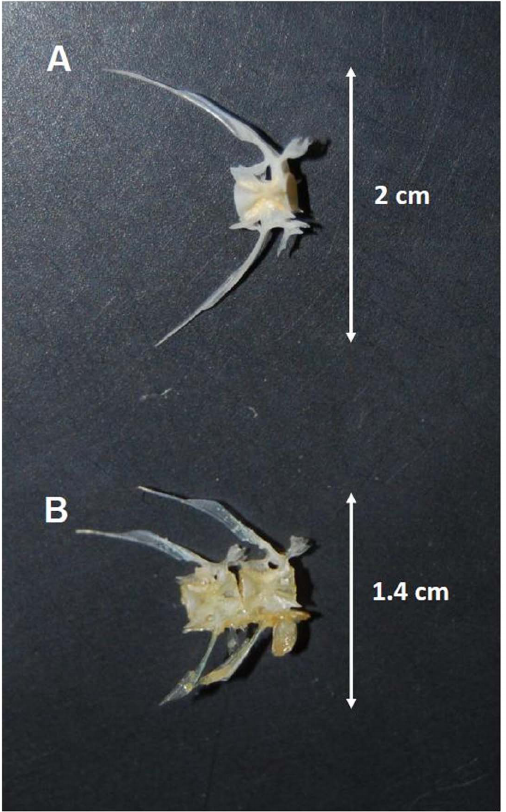
Figure 2. Comparison between a vertebra of a specimen of Scomberesox saurus , (MNHN 5227, 341 mm TL) (A) and two vertebrae from a prey of shortfin mako (individual M1, caught at zone A) (B). Photo Sebastia´n Bito´n.